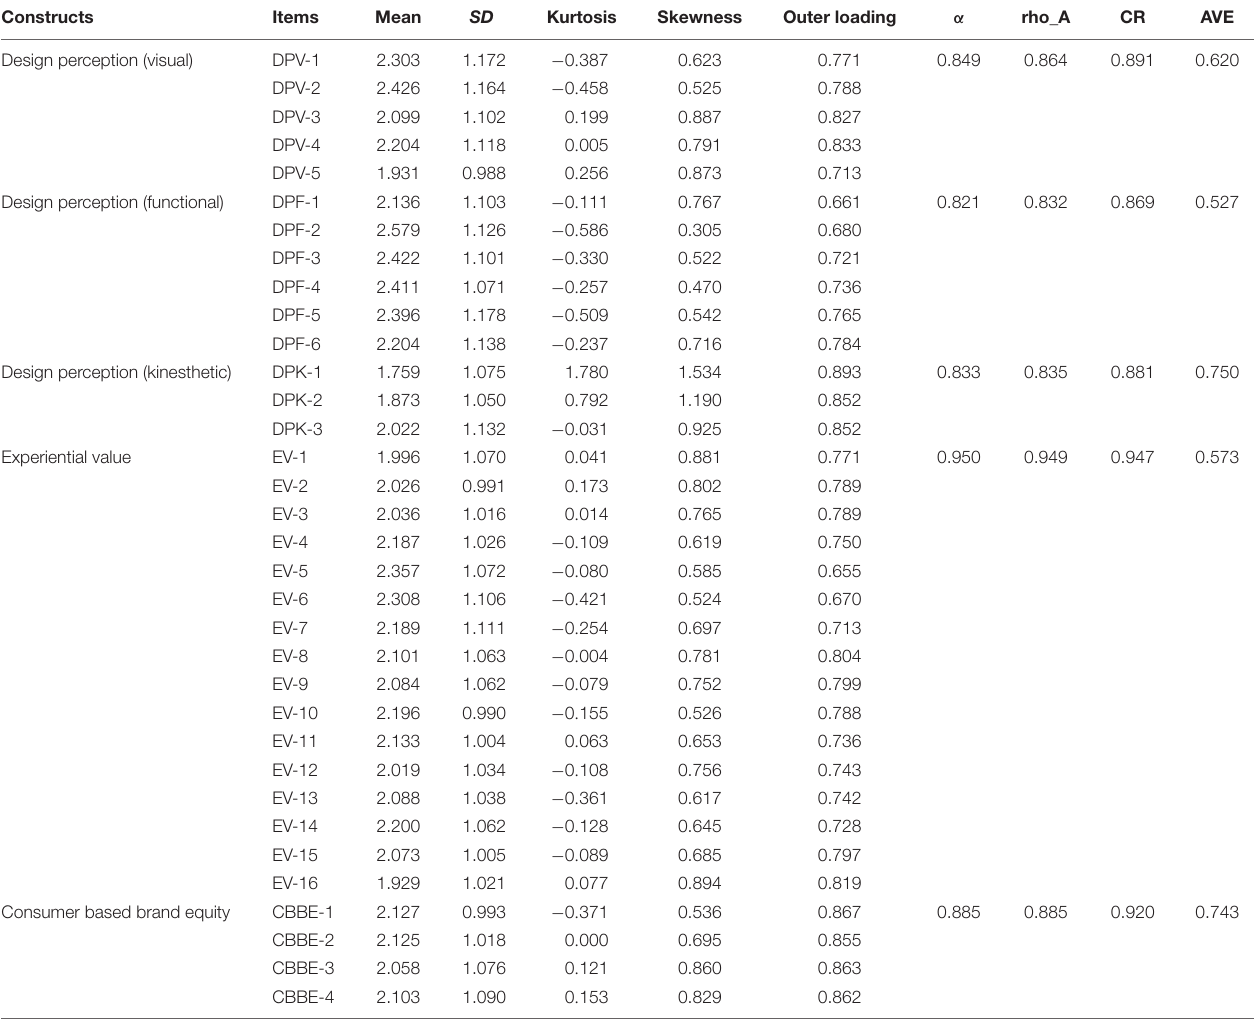
TABLE 2 | Model measurement.